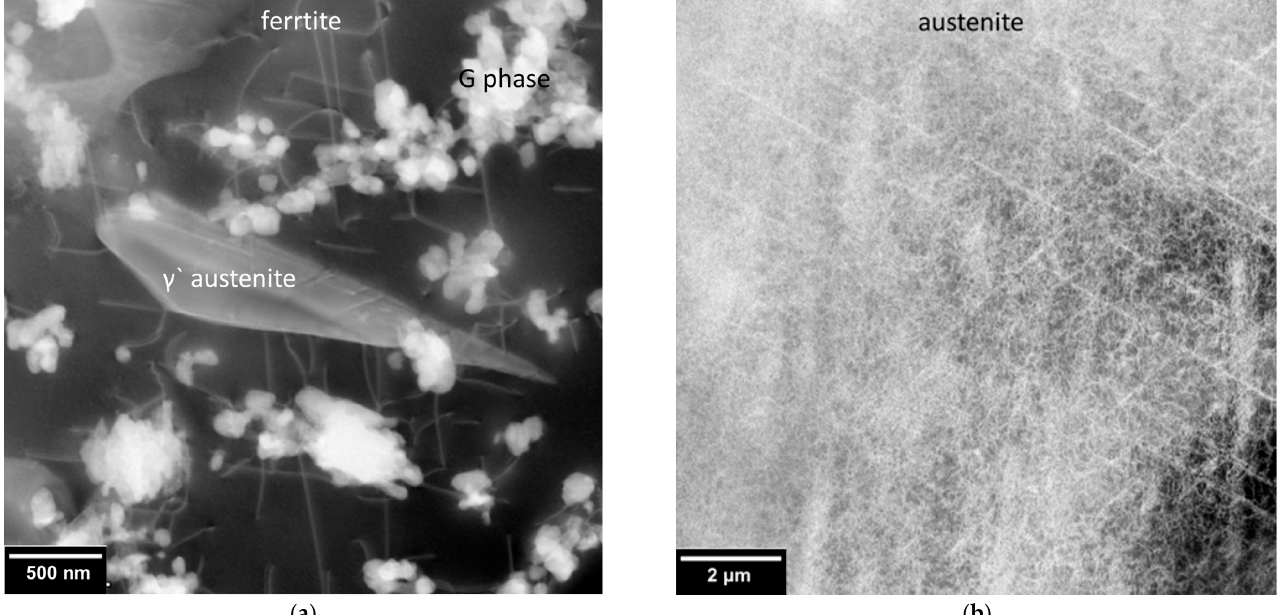
Figure A4. Detailed STEM images of the dislocation arrangement in a ferritic ( a ) and an austenitic grain ( b ) after isothermal fatigue at 600 °C.